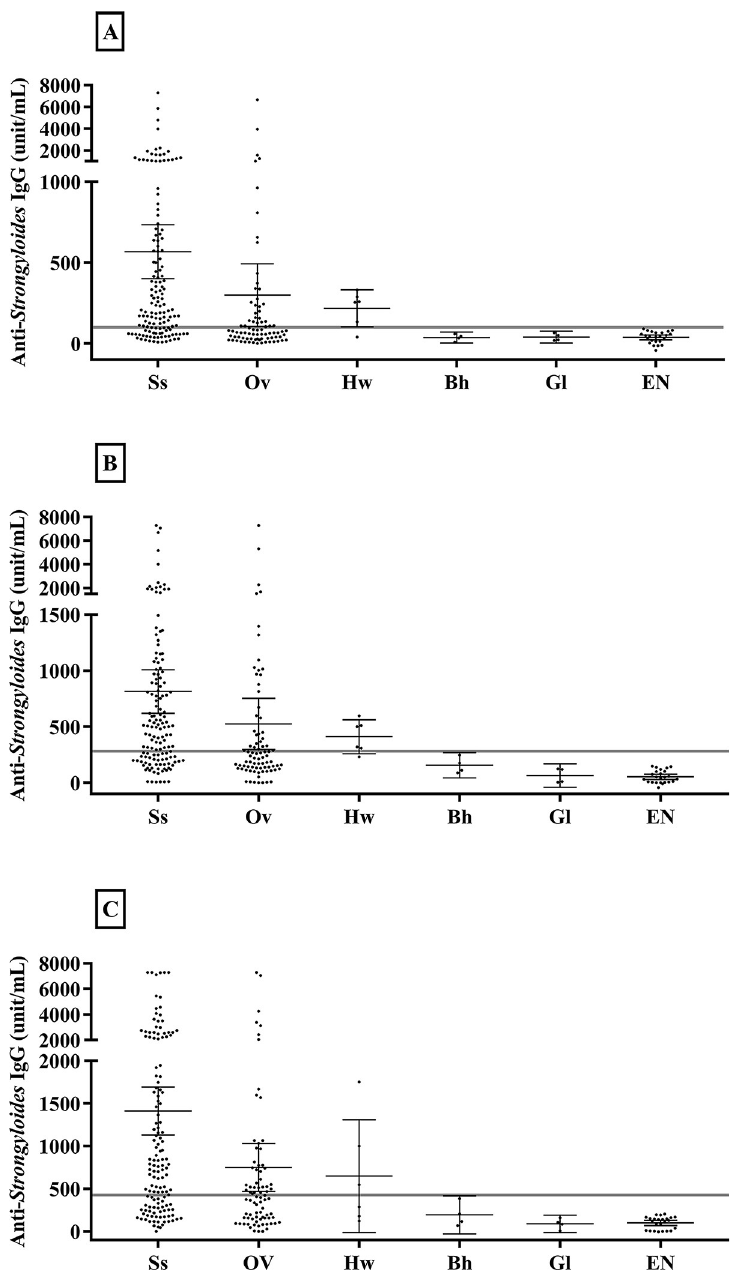
Fig 3. Distribution of anti- Strongyloides IgG levels among individuals with various parasitic infections determined by fecal examination. Urine analysis protocols by Sr-ELISA (A), Ss-ELISA (B), NIE-ELISA (C). Points shown (dots) are individual values of IgG antibody (units/mL of urine). The long horizontal lines indicate the cut-off values of IgG level. Labels for parasitic infections; Ss: S . stercoralis , Ov: O . viverrini , Hw: hookworms, Bh: B . hominis , Gl: Giardia duodenalis , and EN: endemic negative. Short horizontal lines indicate means with lower and upper 95% confidence intervals.